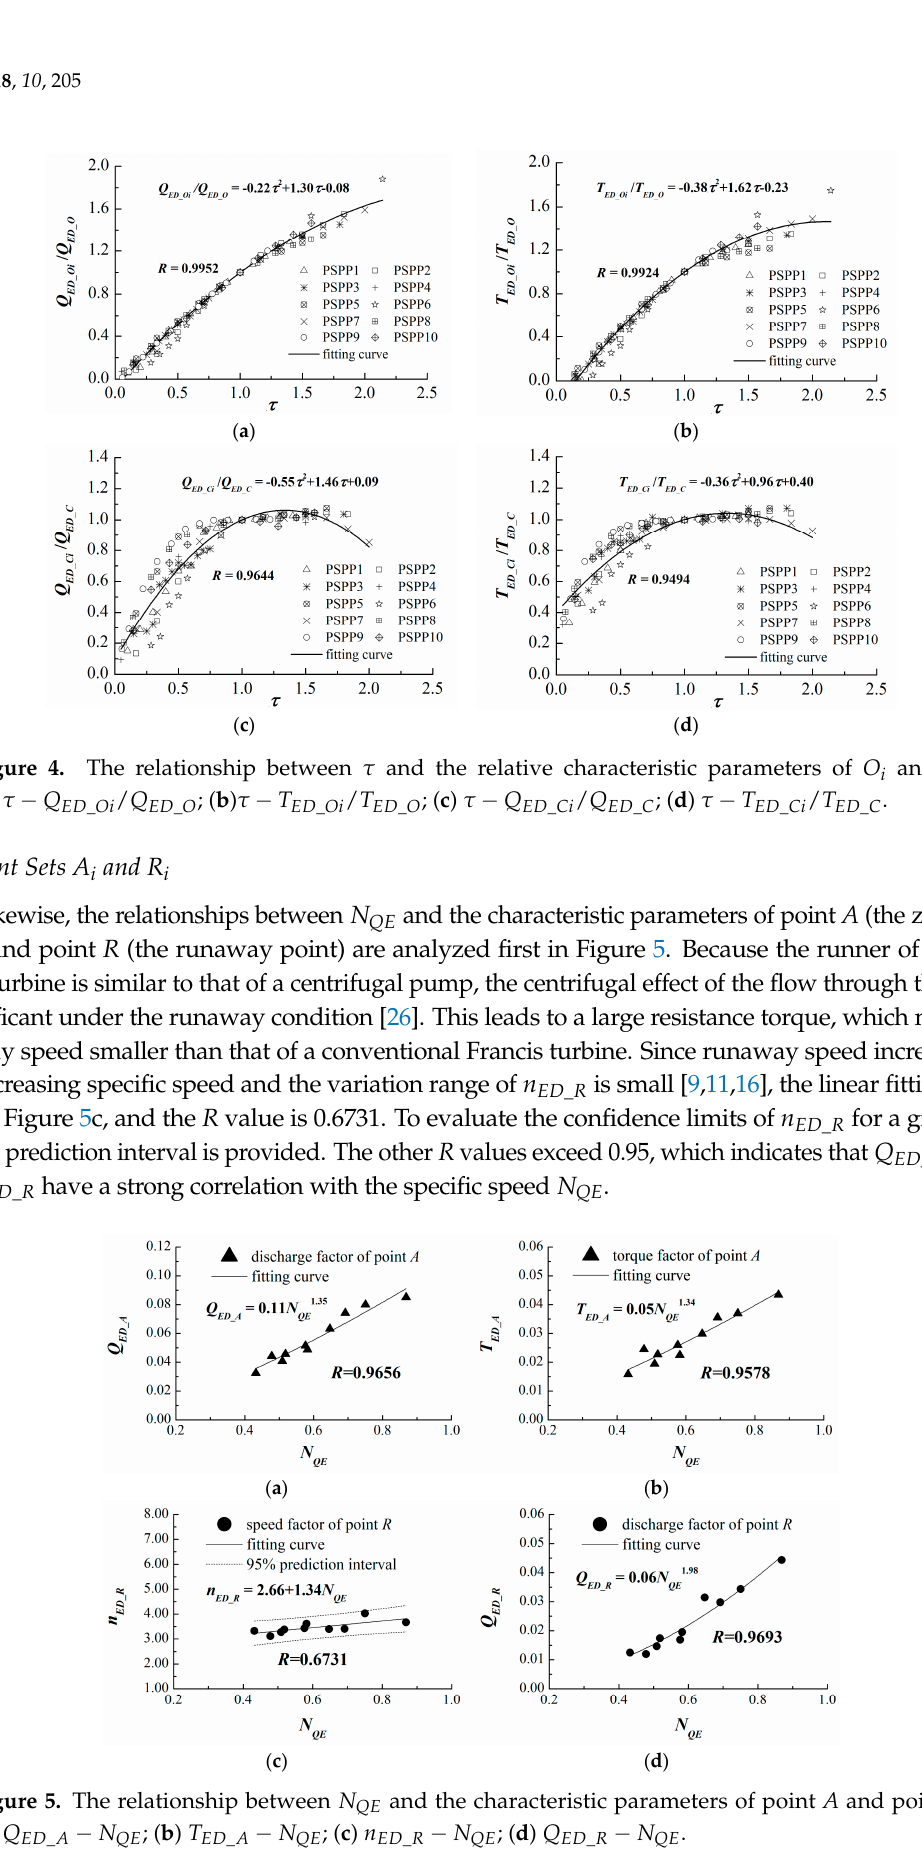
( d ) Figure 6. The relationship between τ and the relative characteristic parameters of A i and R i . ( a ) _